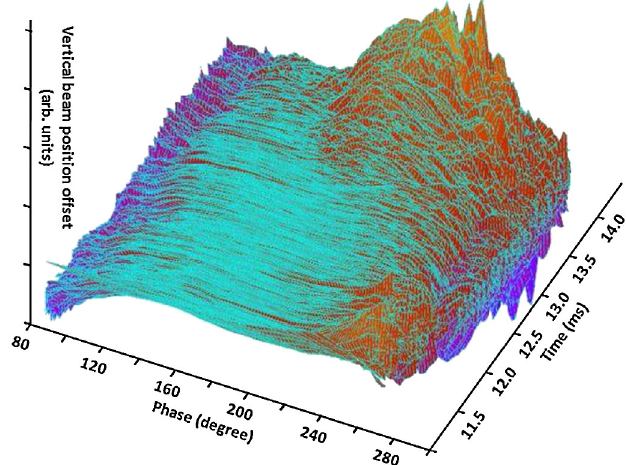
FIG. 10. (Color) The evolution of the vertical instability just before extraction. The phase is rf phase; it is used as longitudinal coordinate along the bunch, the head of the bunch has lower